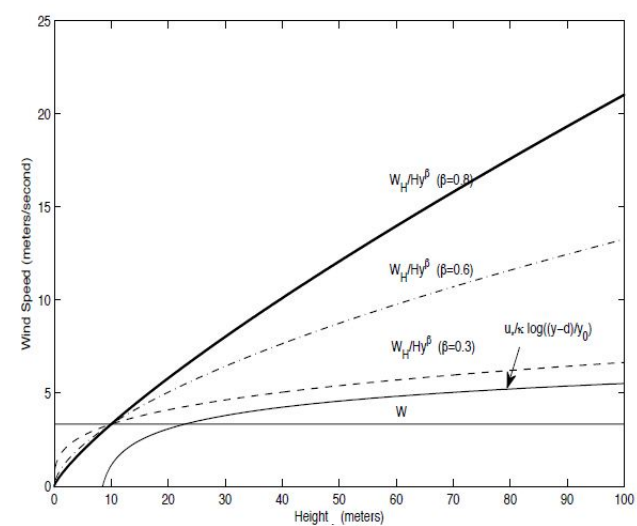
Figure A3. A comparison of the wind profiles discussed in this Section. Shown are three power-law models for different values of the parameter β , together with a logarithmic wind profile and a constant wind profile. We have chosen w H = 5 m/s, and the canopy height to be 10